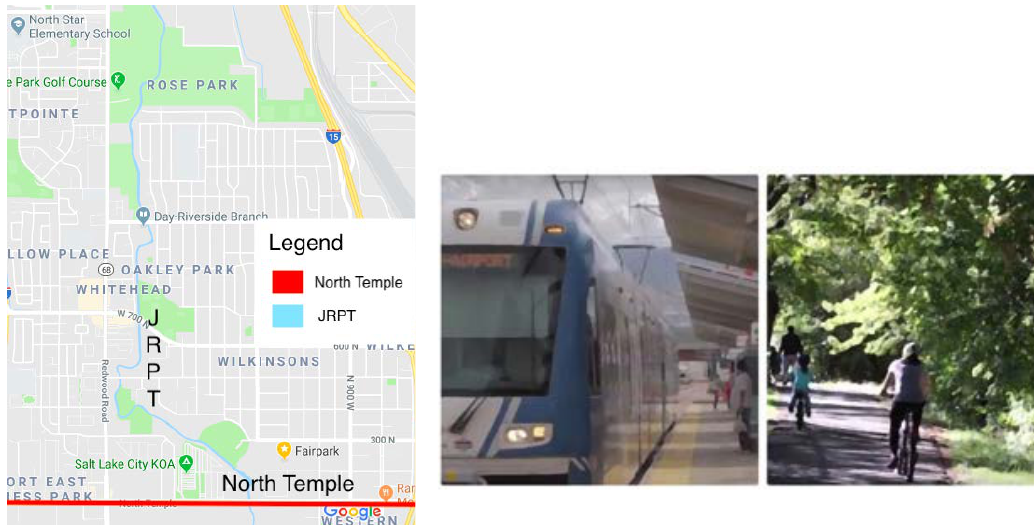
Figure 1. Map and images of North Temple and the JRPT (JRPT). source: created by authors for this paper.